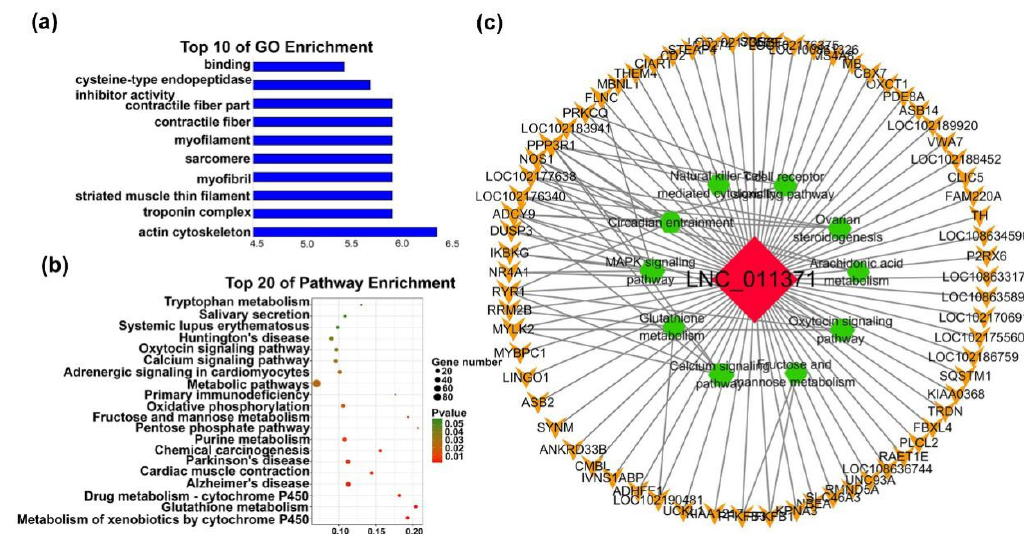
Figure 5. Functional and pathway enrichment of the early module. ( a ) Bar plots showing the top 10 enriched GO terms in M2. The length of the bars indicates significance ( − log 10 P -value). ( b ) Top 20 enriched gene pathway terms of the all M2 lncRNAs. ( c ) Function network of the LNC_011371. The green hexagonal denotes the pathway analysis, the red diamond represents lncRNA, orange V shape represents mRNAs, and the size is expressed in degrees.